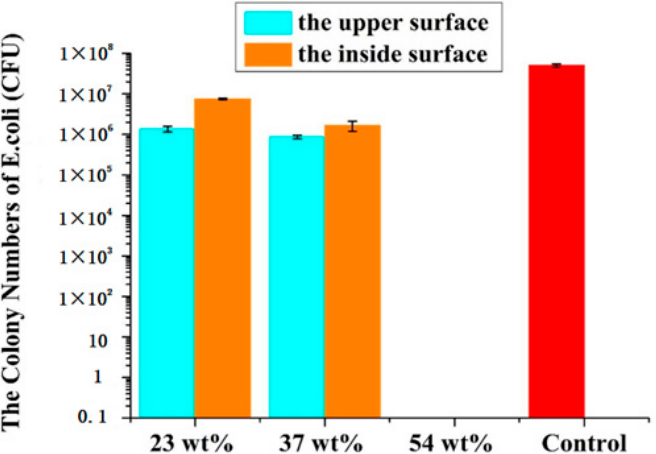
Figure 9. Anti-adhesion experiment: E. coli . colony numbers corresponding to E. coli on the films.